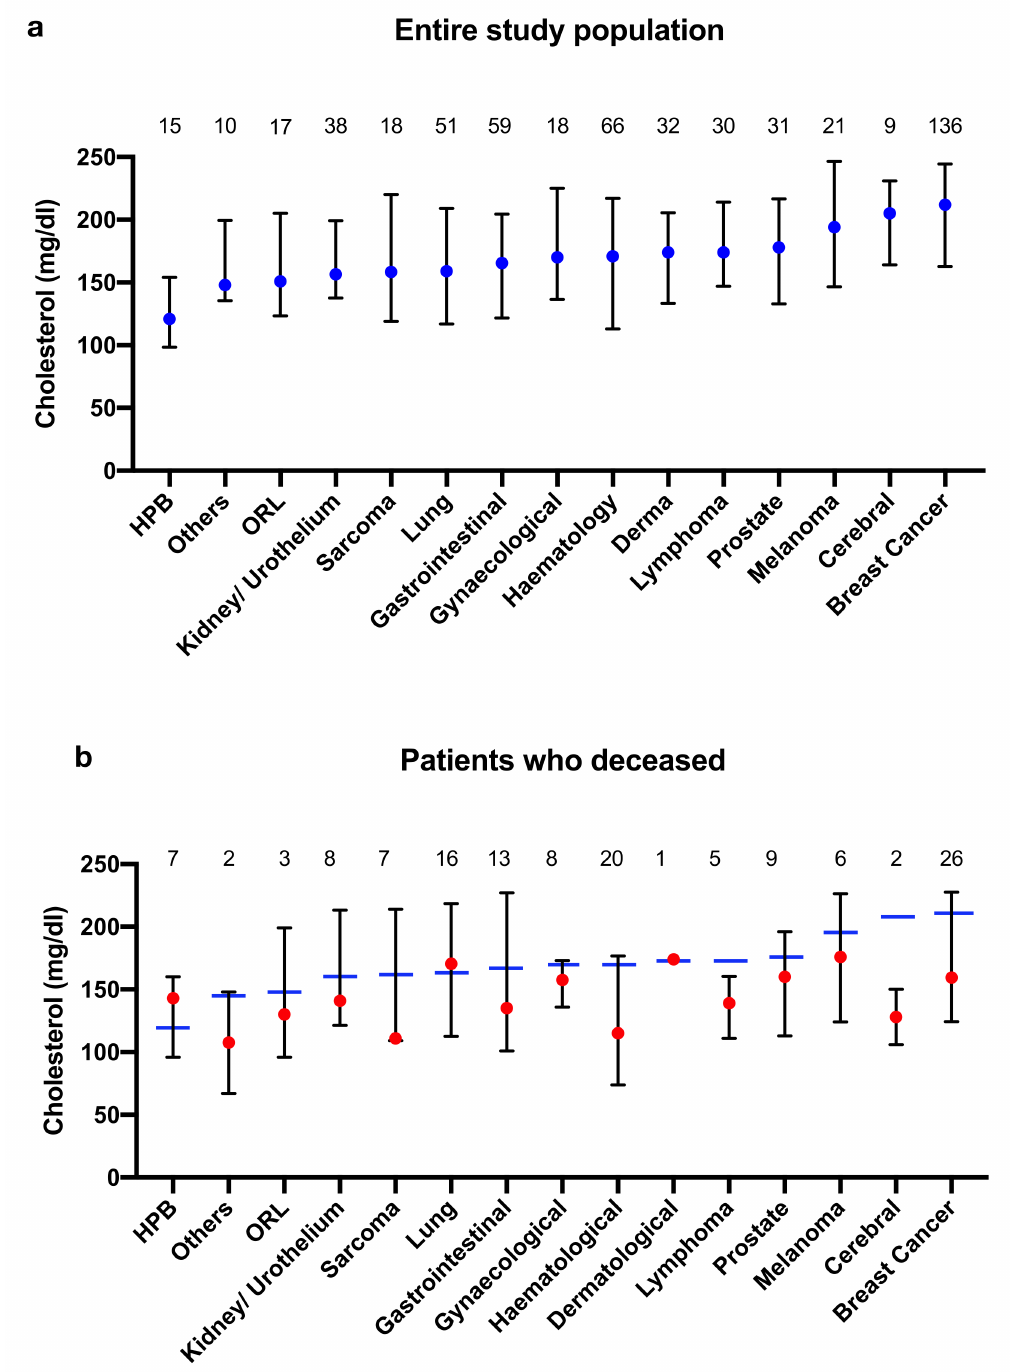
Figure 2. Cholesterol levels based on di ff erent tumour entities ( a ) for the entire study population ( b ) for patients who died. Values are presented as median (marked with blue dot or blue bar for the entire study population and marked with red dot for patients who died) and IQR. Absolute number of patients per group are displayed above the bars. HPB: hepatopancreaticobiliary; ORL: otorinolaryngological. Cholesterol levels of patients with tumours of the hepatopancreaticobiliary system (HPB), otolarnygological (ORL) tumours or rarer tumours (such as germ cell tumours, cancer of unknown primary (CUP); here referred to as “Others”) were below the calculated cut-o ff of 152 mg / dL. Cholesterol levels of patients with other tumours (gastrointestinal / gynaecological tumours, lung cancer, etc.)